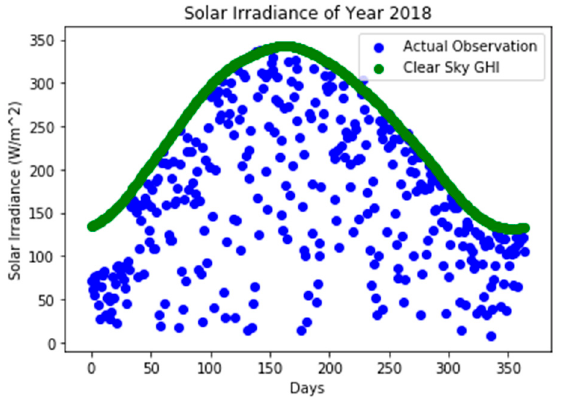
Figure 3. Relationship between actually measured GHI vs. clear sky GHI. Reproduced from [17], MDPI: 2019.